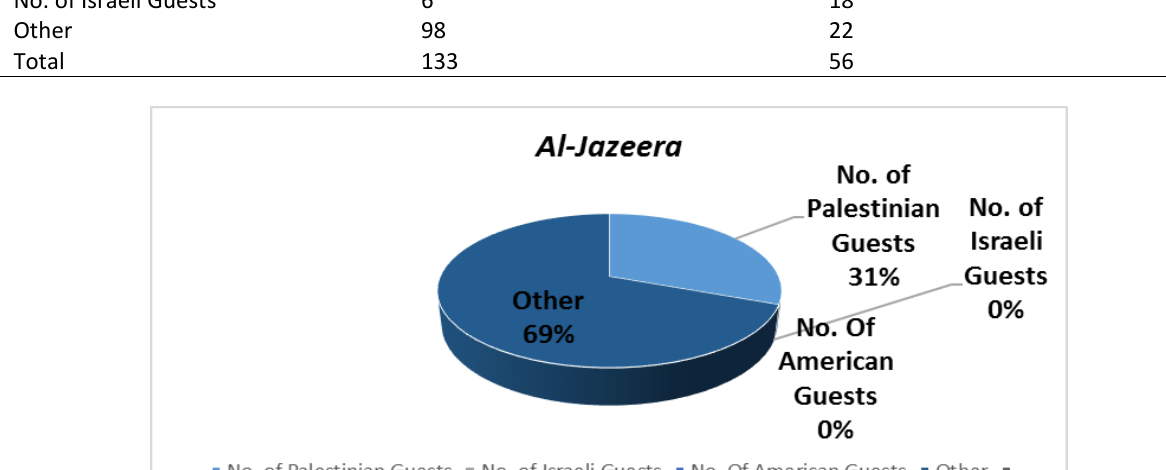
Figure 1. Representation of guests in Al-Jazeera ’s talk show.